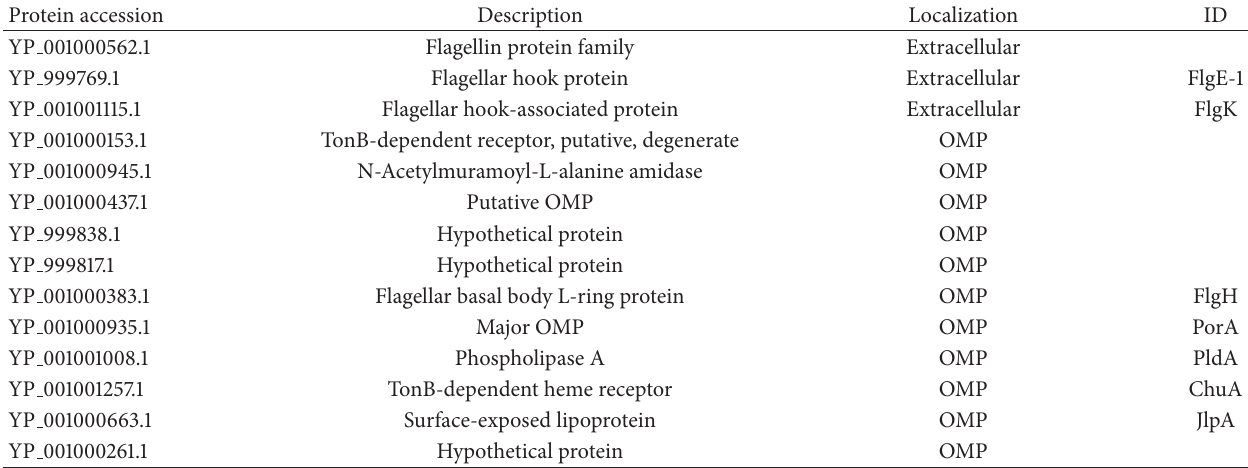
Table3:PotentialvaccinecandidatesselectedafterthewholebioinformaticanalysisprocessincludingVaxignandVaxiJenprograms,BCPreds and AAP algorithms, and blast analyses. Of 1758 ORFs encoded by C. jejuni , strain 81-176 genome, 14 proteins were selected as vaccine